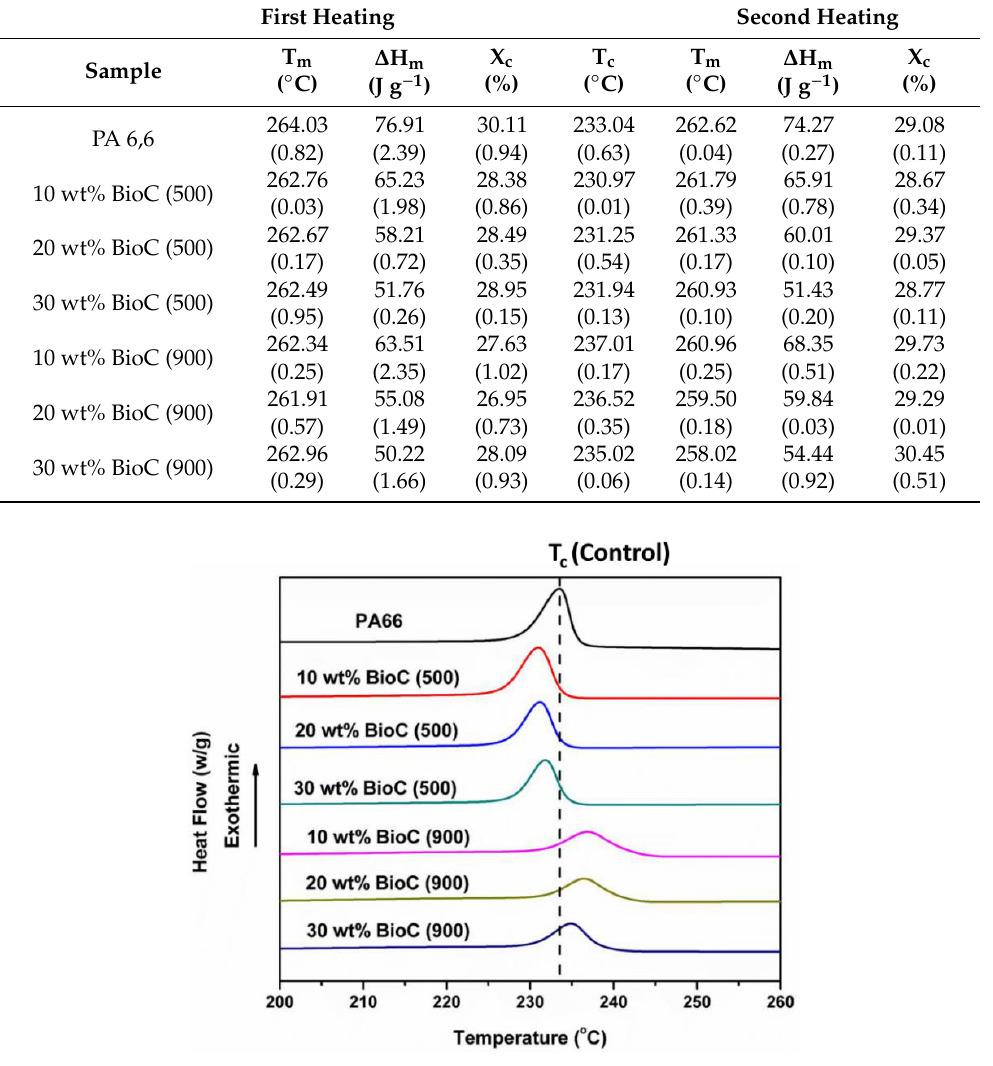
Table 2. DSC data of PA66 and its composites with standard deviation in parenthesis, Heat 1 includes the first heating and cooling curve.